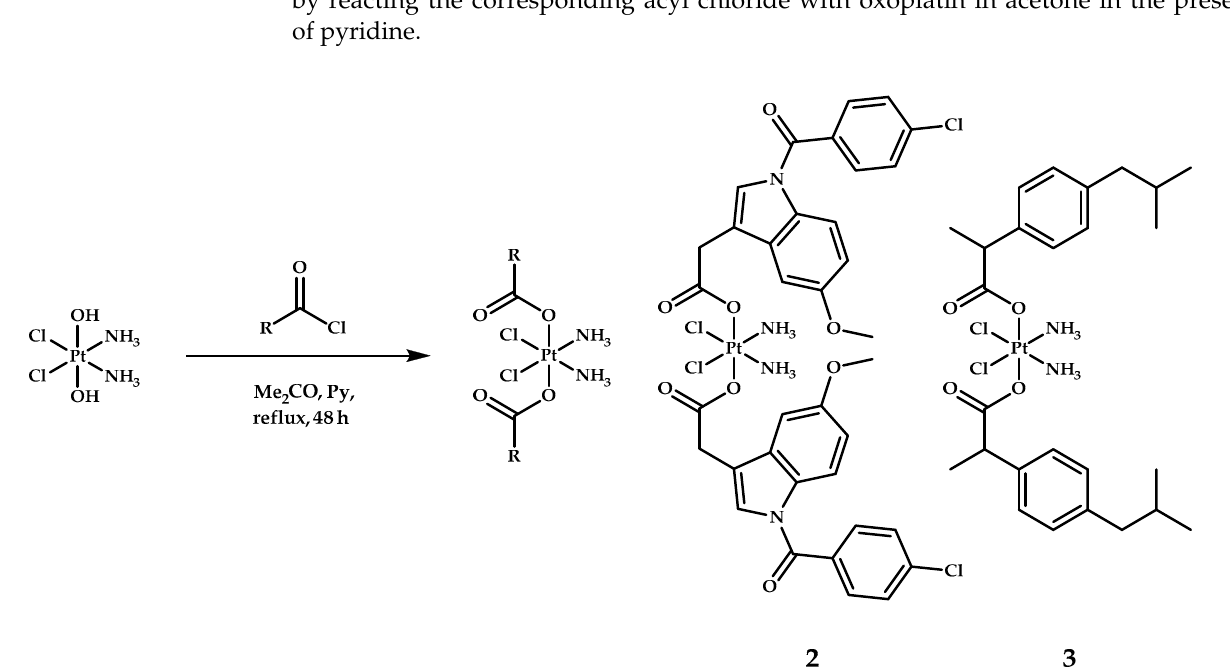
Table 3. Antiproliferative activity of cisplatin and platinum(IV) prodrugs 2 and 3 on HCT-116 (colorectal carcinoma), OVCAR3 (ovarian cancer), MDA-MB-231 (triple negative breast cancer), and 1483 HNSCC (head and neck squamous cell carcinoma) cell lines. The ability of cells to express cyclooxygenase-2 (COX-2) is indicated by “-“ (non-expressing), “+” (expressing), “++” (strongly expressing).